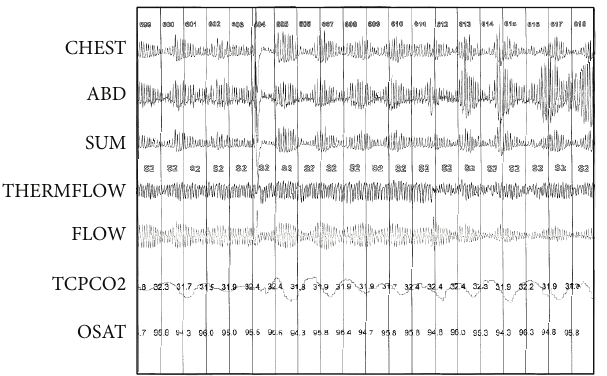
Figure 1: Cheyne-Stokes respiration in the child before heart transplant.